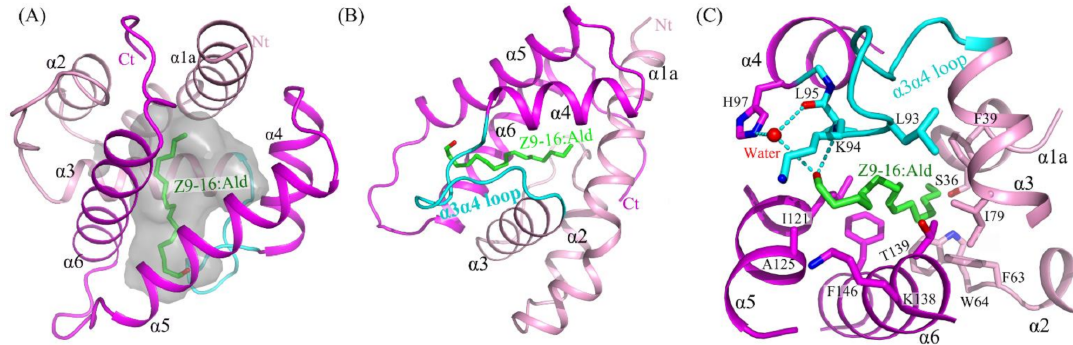
Figure 3. The binding pocket and its binding site details. ( A ) HarmPBP1 has a “C” shaped ligand- binding cavity. ( B ) The binding of Z 9-16:Ald (green) in the HarmPBP1 binding pocket. ( C ) Detailed interaction of Z 9-16:Ald. Hydrogen bonds, dashed lines. α 3 α 4 loop,